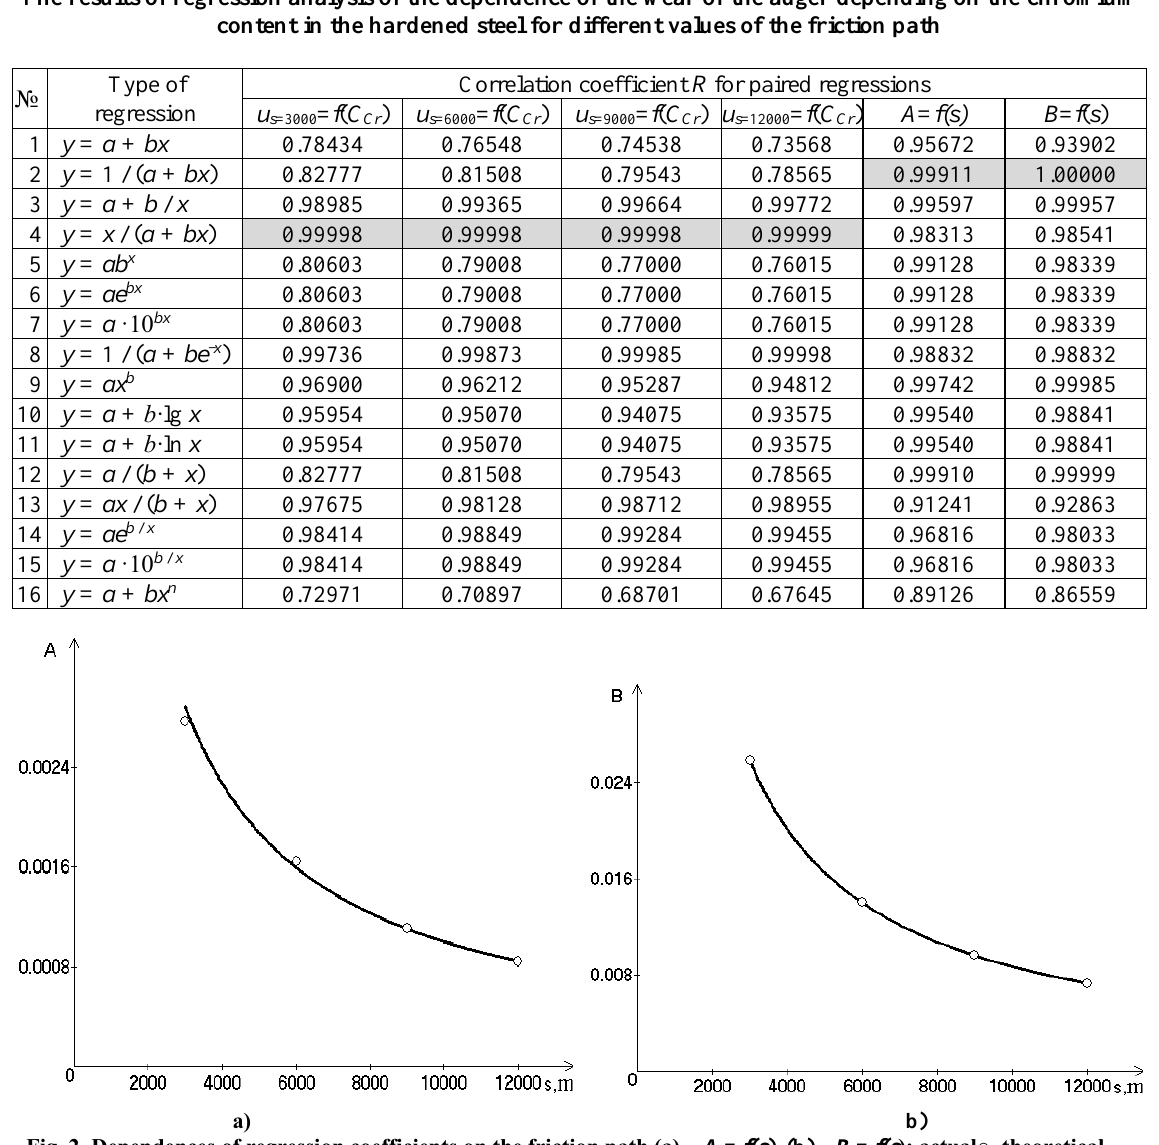
Fig. 2. Dependences of regression coefficients on the friction path (а) – A = f ( s ), (b) – B = f ( s ): actual○, theoretical